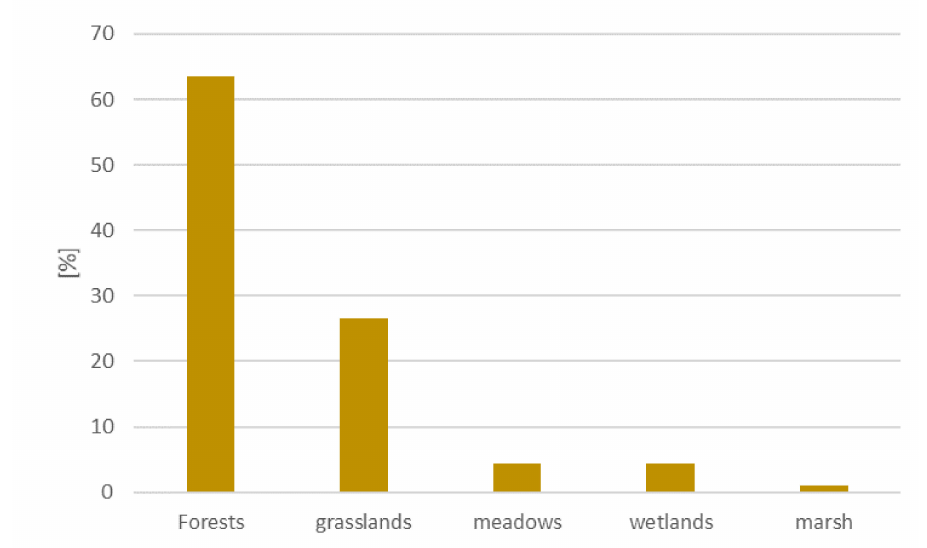
Figure 12. Percentage of the number of studies focused on different types of vegetation in the analyzed set of publications.